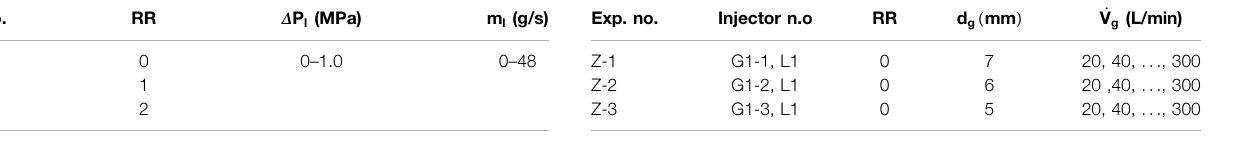
TABLE 6 | The working conditions of Z-1, Z-2, and Z-3 injectors. Exp. no. Injector n.o